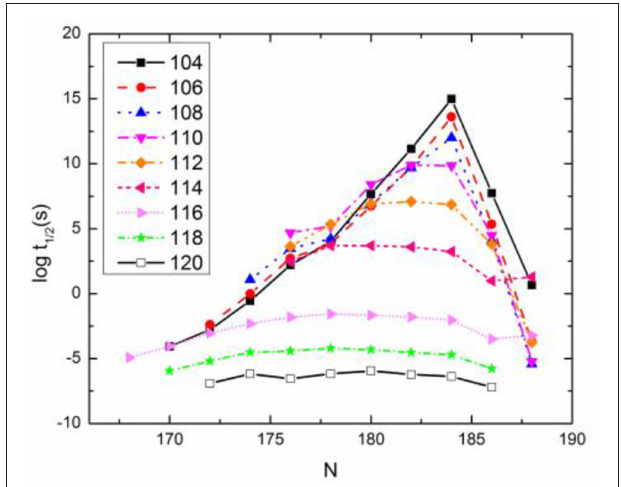
FIGURE 1 | The predicted [22, 23] half-lives of even-even heavy nuclei vs. their neutron number.